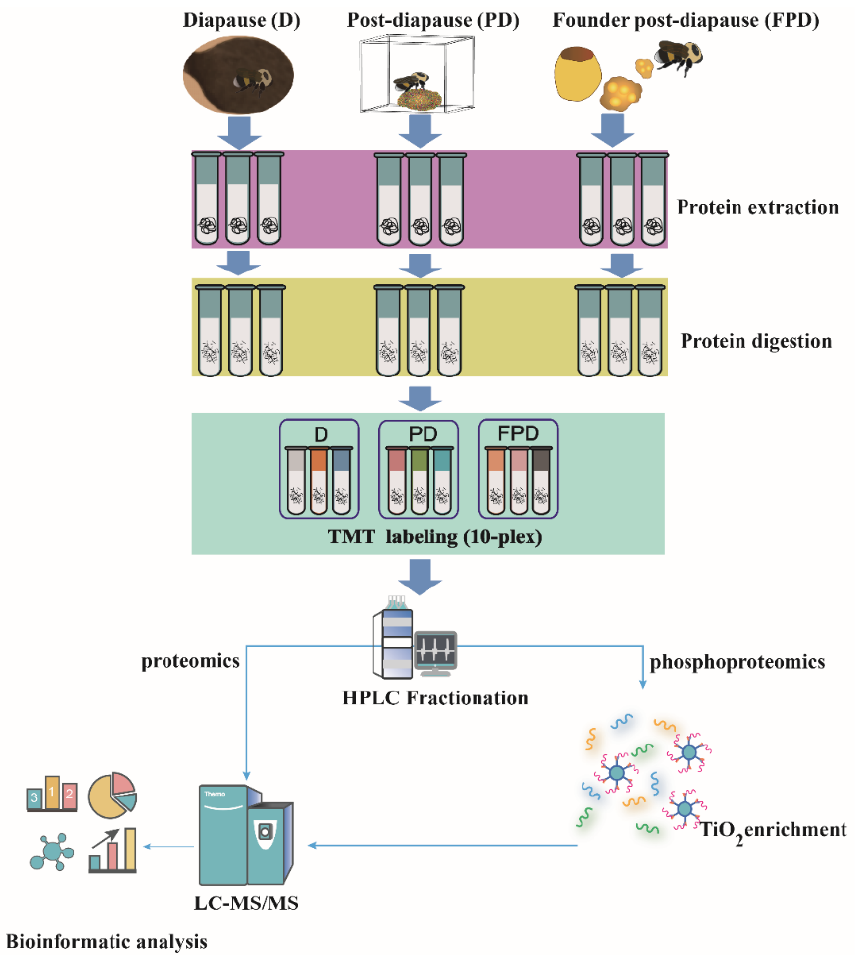
Figure 1. The experimental workflow for the quantitative proteomics and phosphoproteomics analyses of three diapause stages in B. terrestris .